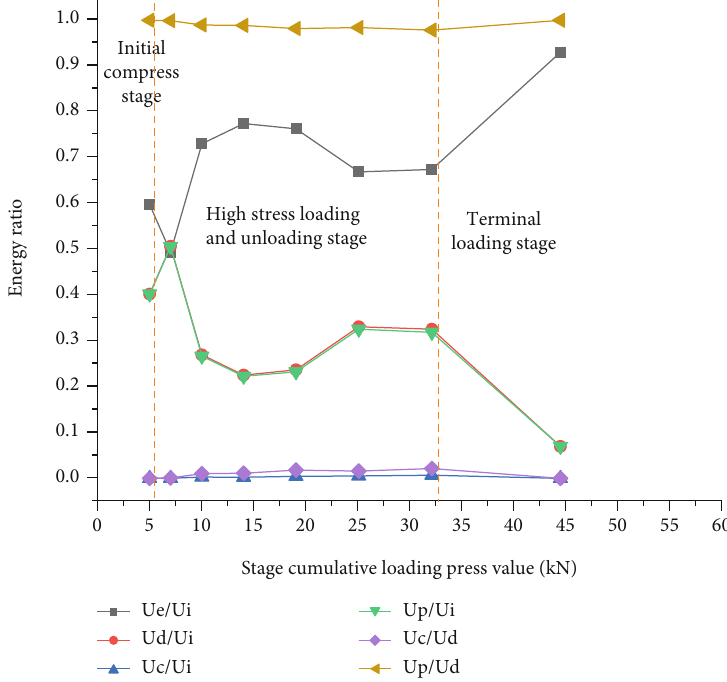
Figure 15: Relationship between energy proportion and stage cumulative loading press value with sample